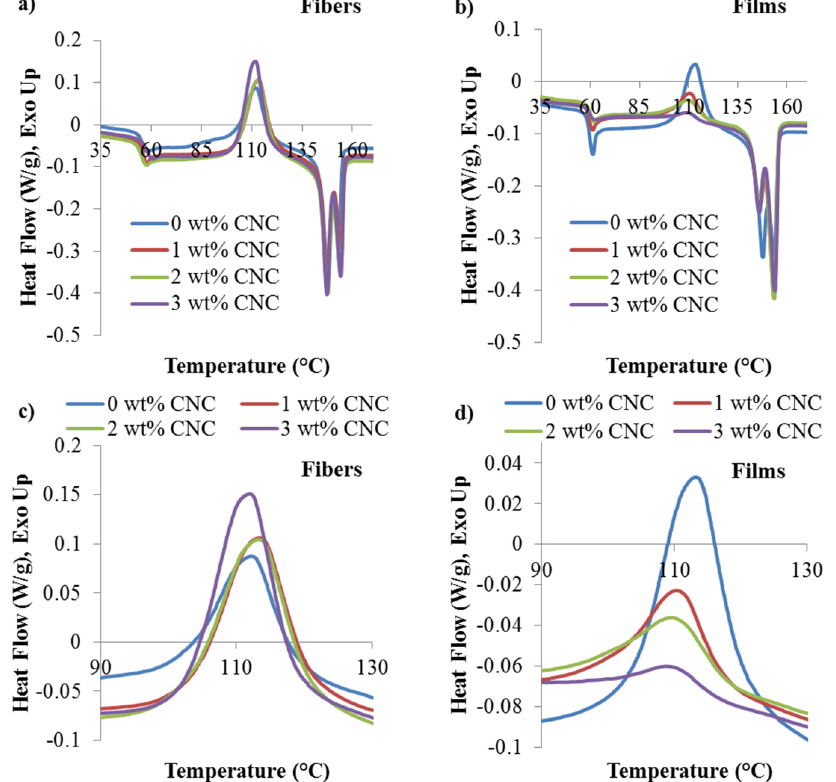
Figure 2. Non-isothermal initial heating thermograms of CNC/PLA ( a ) fibers; ( b ) films; ( c ) fiber cold crystallization peaks; and ( d ) film cold crystallization peaks. Table 1. Degree of crystallinity ( χ ), cold crystallization enthalpy ( Δ H c ), and cold crystallization